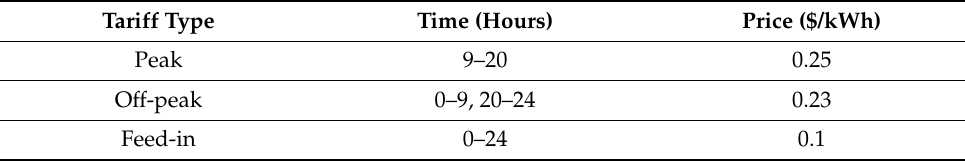
Figure 4. Weekday and weekend power consumption for a macro base station in commercial and residential areas. Table 1. Electricity